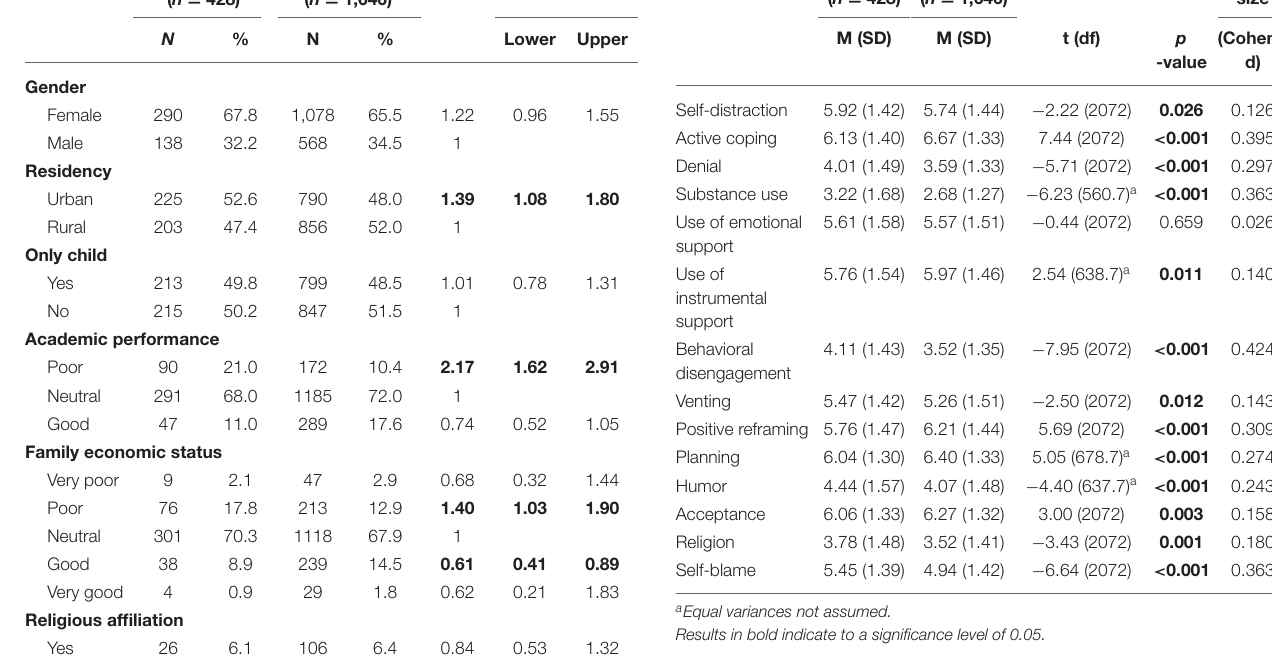
TABLE 1 | Sociodemographic background of non-suicidal group and suicidal group in the study. Suicidal ( n = 428)